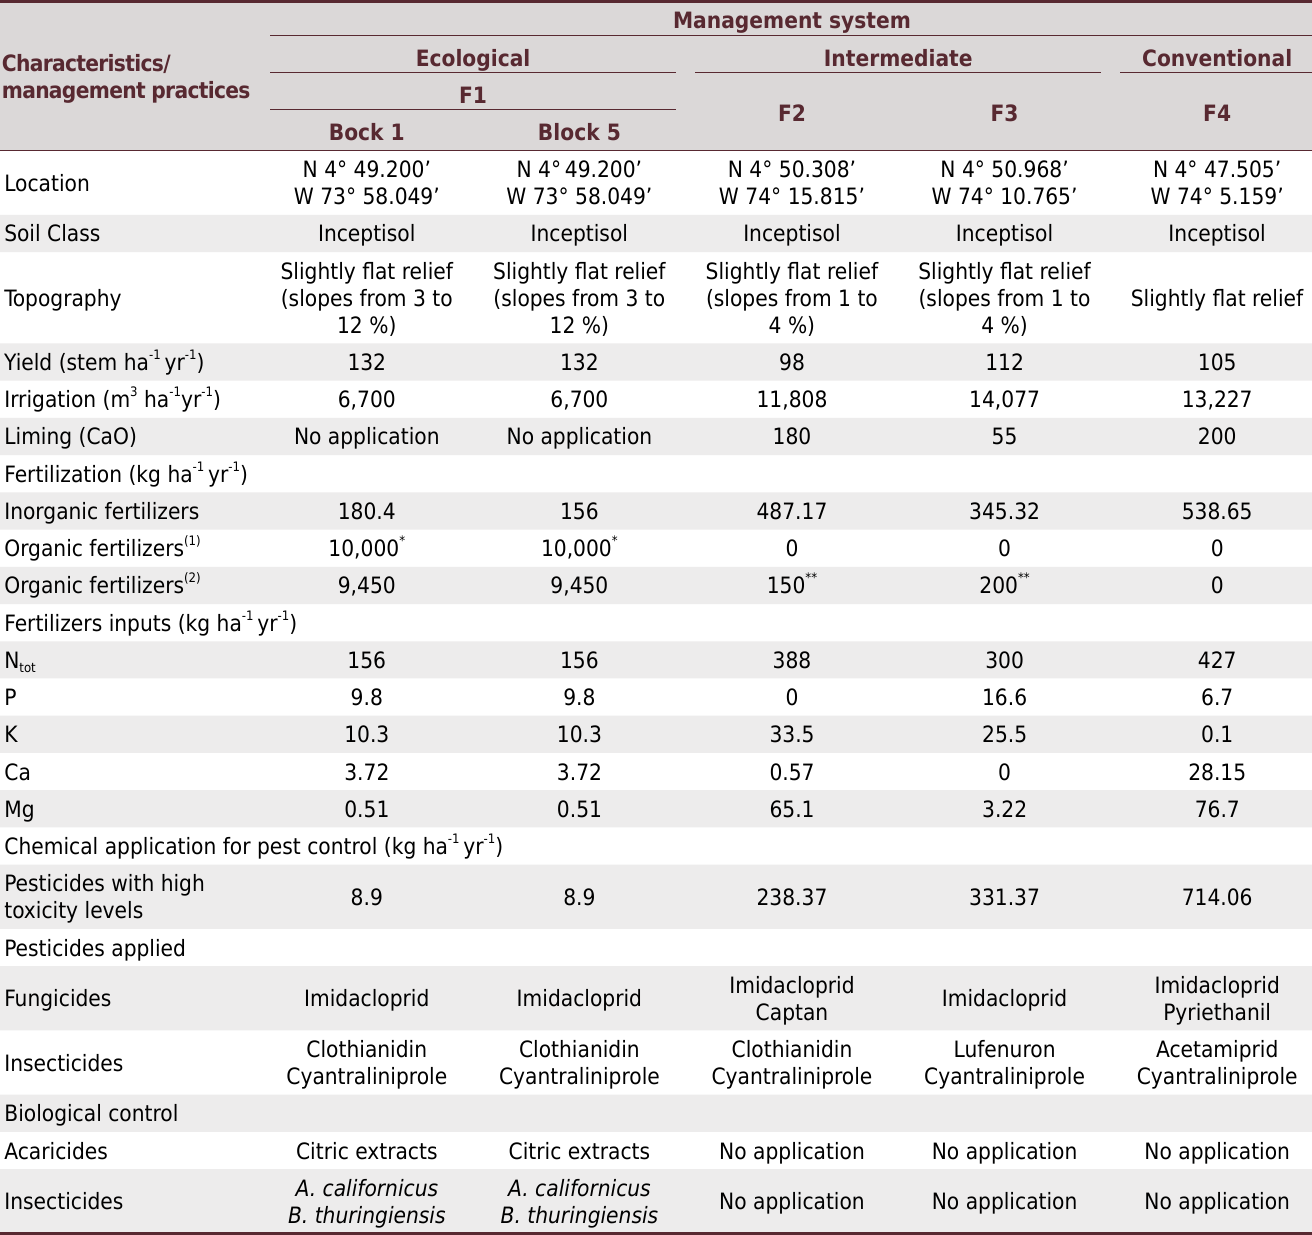
Table 1. Characteristics and management practices at the sampling